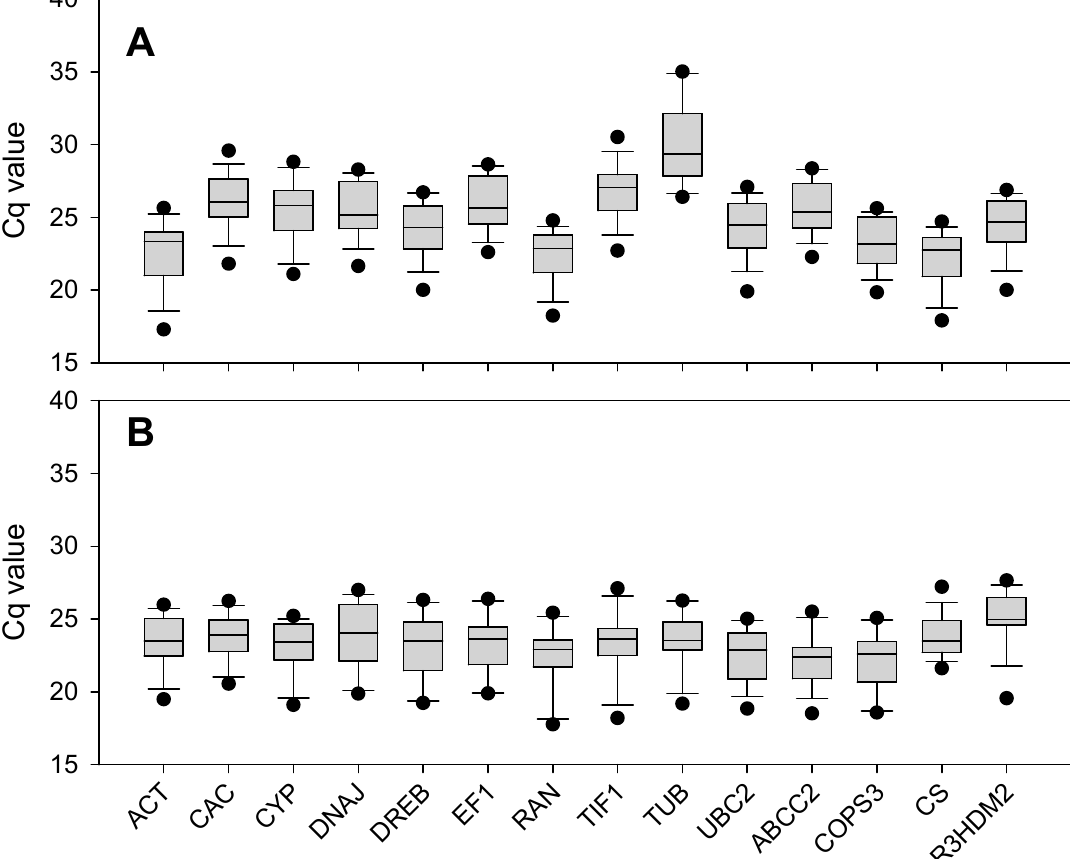
Figure 2. Distribution of threshold cycle (Cq) values for candidate reference genes: distribution of threshold cycle (Cq) values of ( A ) G. uralensis and ( B ) G. inflata in all samples. Boxes: the interquartile range; lines across the boxes: median; the line above and below the boxes: the maximum and minimum values; and black dots: outliers.